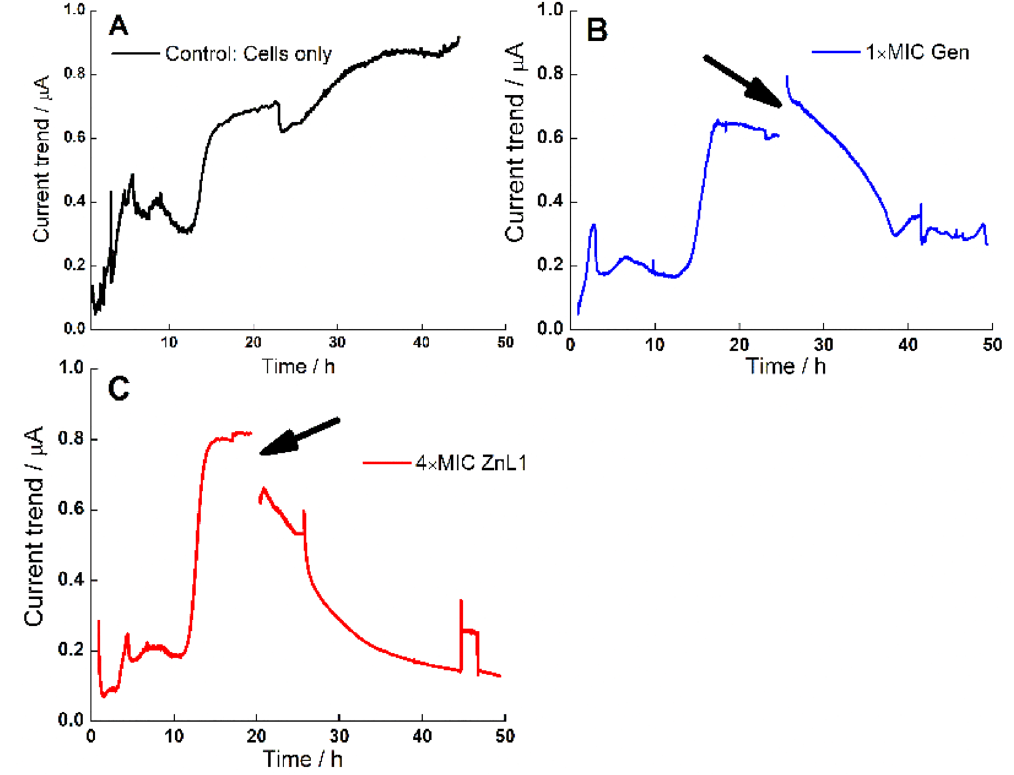
Figure 6. Representative chronoamperometric plots of current generated by pre-formed biofilms of A. baumannii after addition of ZnL1 (4 × MIC) in comparison with addition of Gen (1 × MIC) and untreated controls ( A ) untreated control cells (black trace); ( B ) cells treated with 1 × MIC Gen (blue trace) and ( C ) Cells treated with ZnL1 (4 × MIC) (red trace). Point of addition of the drug is marked with an arrow